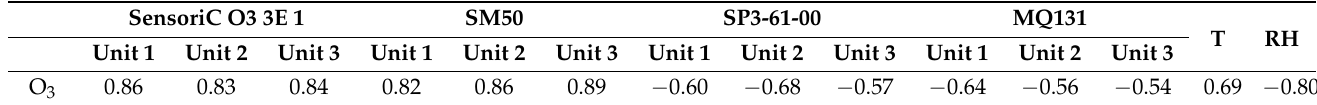
Table 2. Pearson’s correlation coefficients of MLU 400 reference data (O 3 ) vs. sensor data and meteorological data (T—temperature, RH—relative humidity) for the entire study